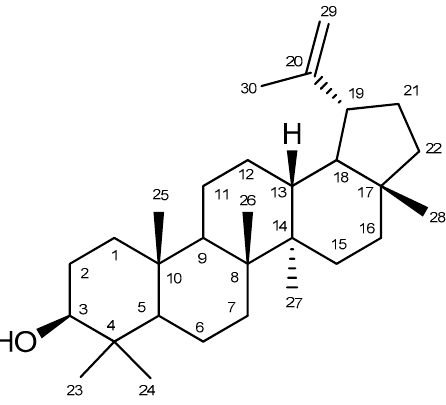
Figure 11. Chemical structure of lupeol.